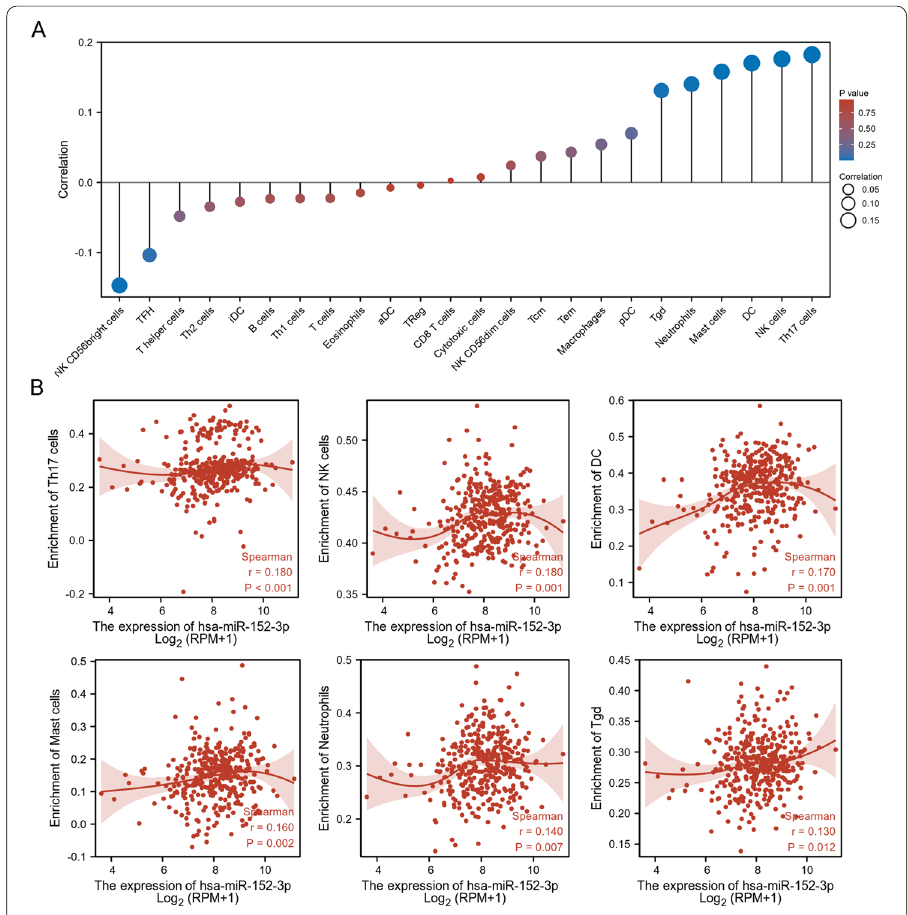
Fig. 10 The association between miR-152-3p and immune infiltration. ssGSEA algorithm was implemented to evaluate miR-152-3p mediated immune cell enrichment ( A ). The top six correlated immune cells, including Th17 cells, NK cells, DC, mast cells, neutrophils and Tgd ( B